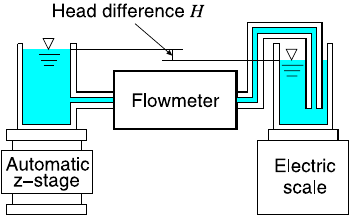
Fig. 2 Schematic diagram of the setup for pumping by a head di ff